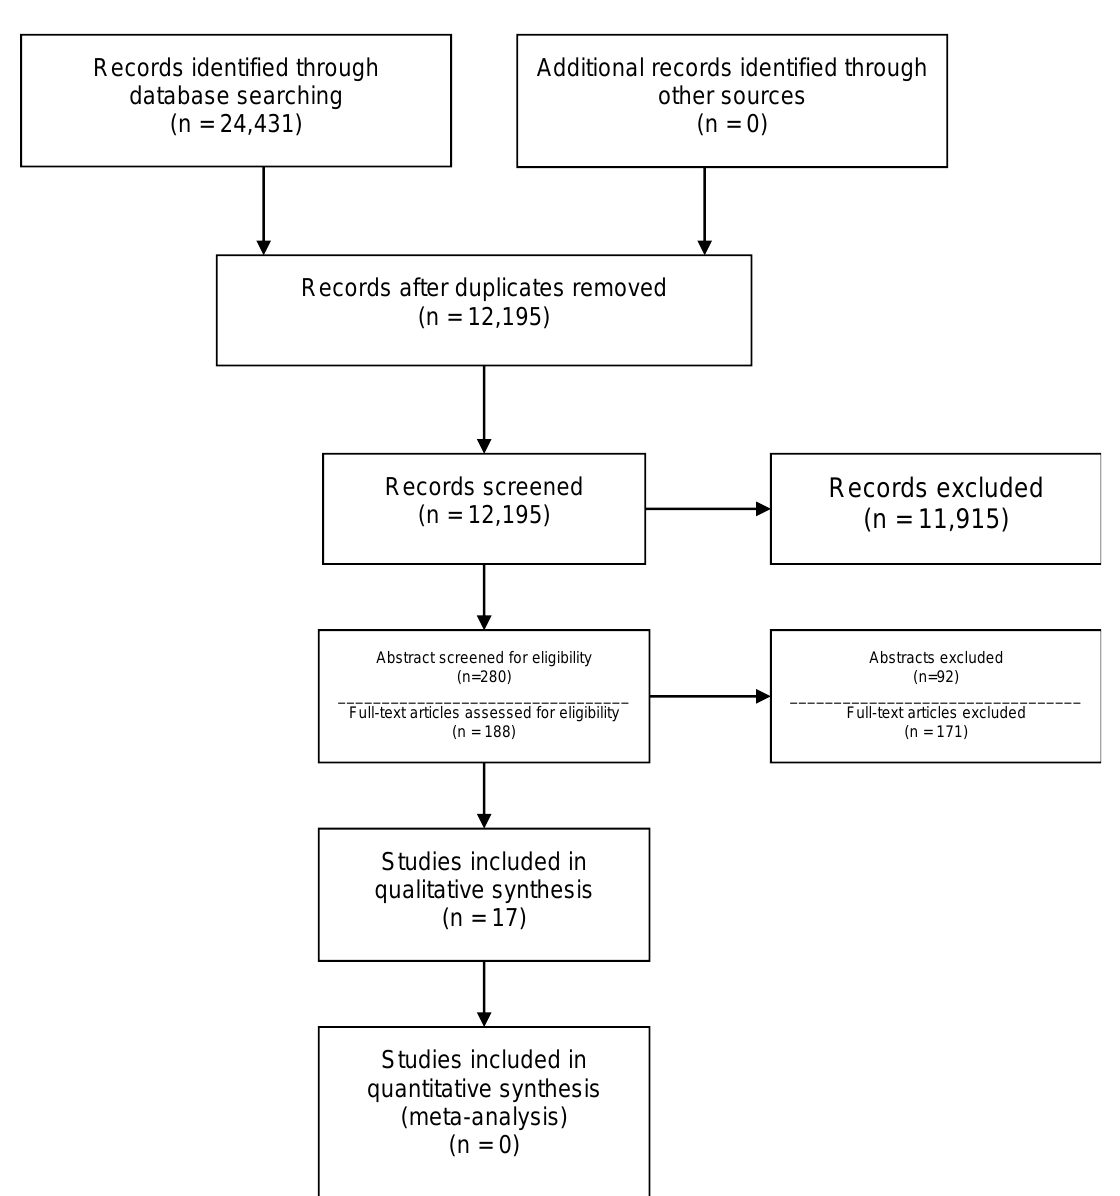
Figure 1. Flowchart of the study selection process (adapted from [9]).